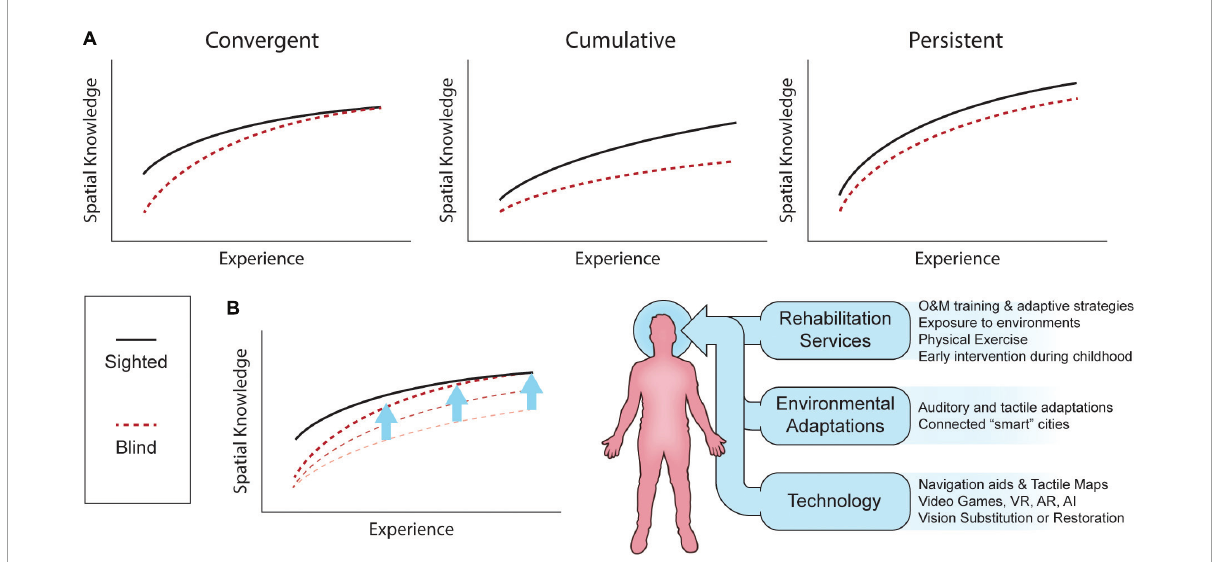
FIGURE6 Spatial knowledge acquisition by sighted and blind individuals. (A) Three different models of spatial knowledge acquisition: the convergent, cumulative, and persistent models. (B) Spatial knowledge acquisition can be improved by the combination of rehabilitation services, environment adaptations and technologies. Adapted, with permission, from Schinazi et al. (2016). AI, artificial intelligence; AR, augmented reality; VR, virtual